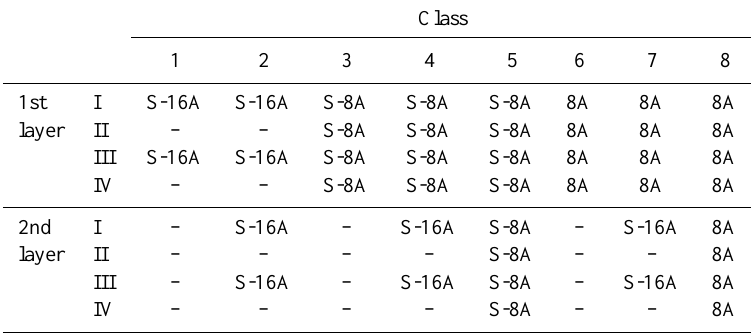
Table 2. Different nozzle combinations implemented in this study.